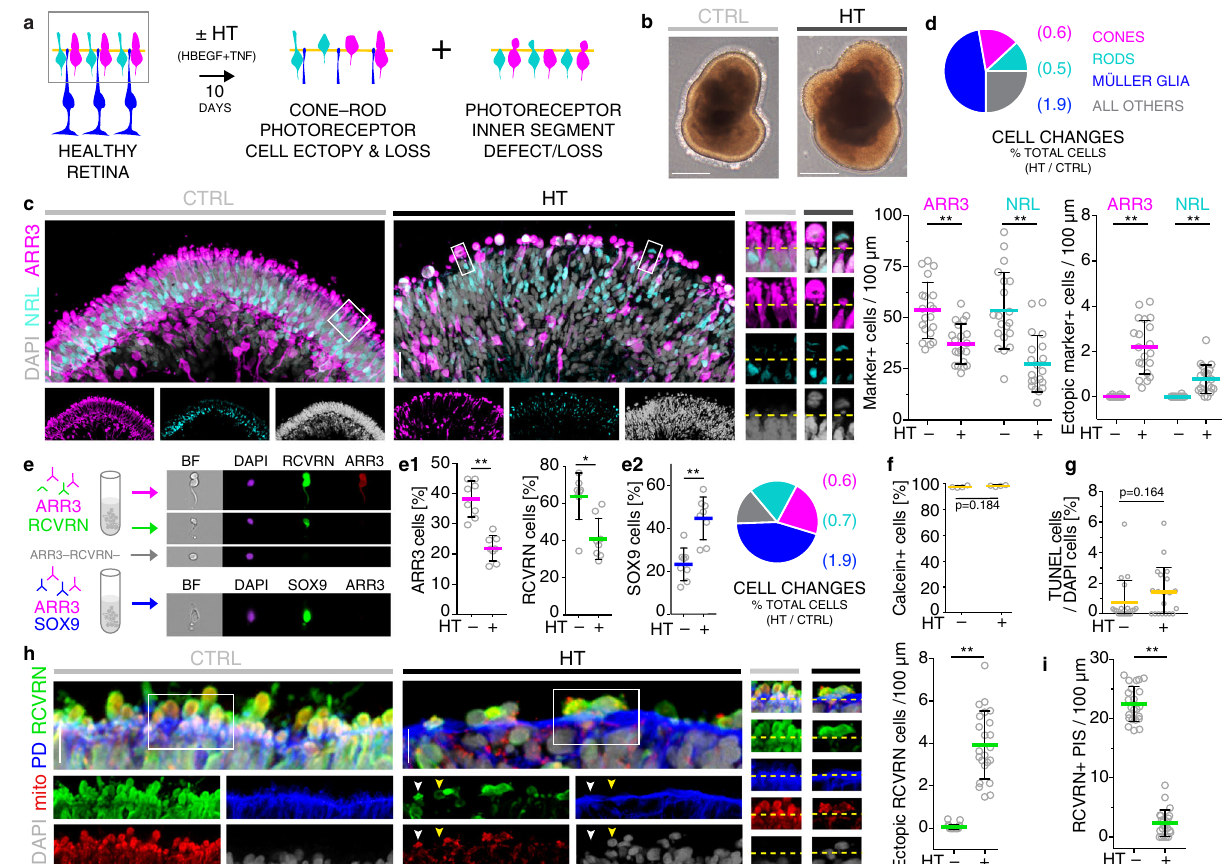
fl ow-cytometry data. e3 Piechart: HT-HRO cell composition. Numbers in parenth- esis: fold change of HT-HROs compared to controls. Colors as depicted in ( d ). f Flow cytometry of Calcein live-dye staining, and ( g ) TUNEL staining on cryosec- tions. h , i Immunostaining analysisof photoreceptor marker RCVRN on HRO serial sections: shows ectopic (extruded) photoreceptors outside of the OLM, and ( h , i ) pathologic changes and loss of RCVRN- and mitochondria-positive (mito) photo- receptor inner segments (PIS). Filamentous actin: visualized by Phalloidin488 (PD) to determine the OLM/apical boundary. c , e – i Graphs (mean±SD) and statistics over n . Two-sided Student ’ s t test; ** P <0.0001, * P =0.0023. c , g – i Graphs: each circle represents one HRO ( n ) derived from N =4 with n ≥ 5/ N ; 2 hiPSC lines (Sup- plementary Data 2). e Graphs: each circle represents one set (s) of 6 − 9 pooled HROs(2 − 3s/ N , N =3,2hiPSClines). f Graphs:eachcirclerepresentscellsanalyzed from one sample (s); two pooled HROs/s; N =1 independent experiment. e , f Mean±SDand statistics over samples. Scalebars: b 500 µ m, c , h 50 µ m.Source data are provided as a Source Data fi